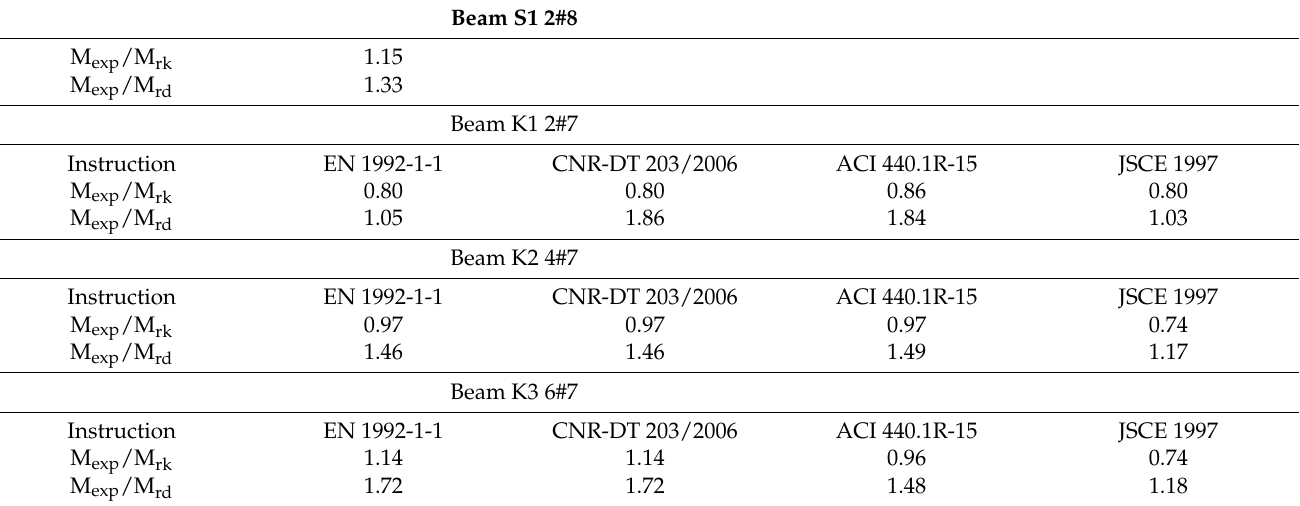
Table 5. Calculation of beams load capacity ratios for different